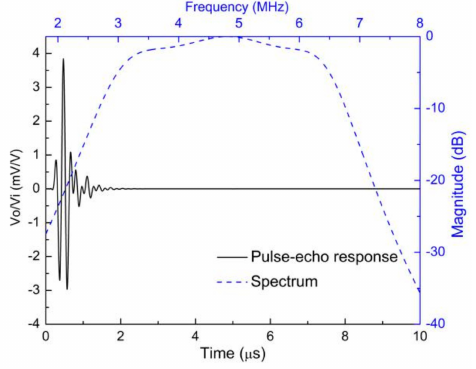
Figure 7. The modeled pulse–echo response and the FFT spectrum of the 5 MHz transducer.